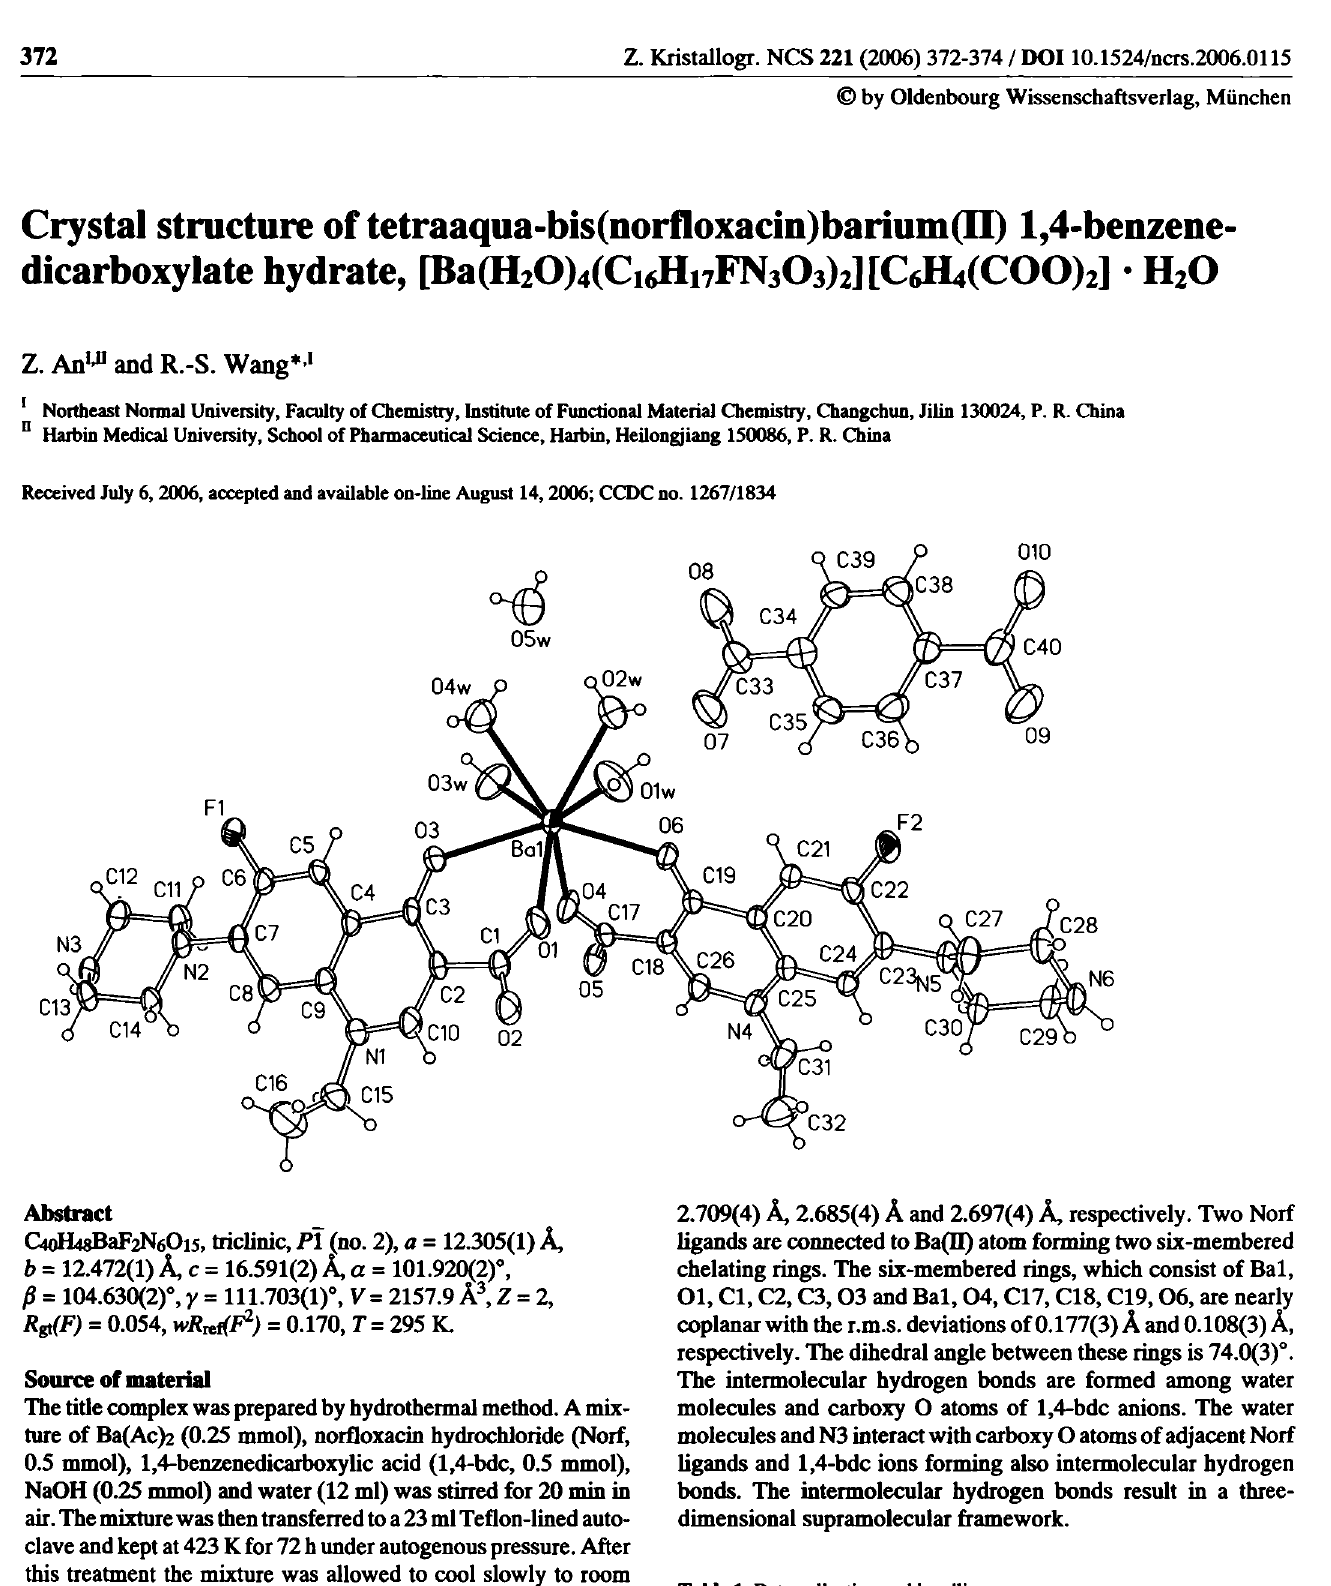
Table 1. Data collection and